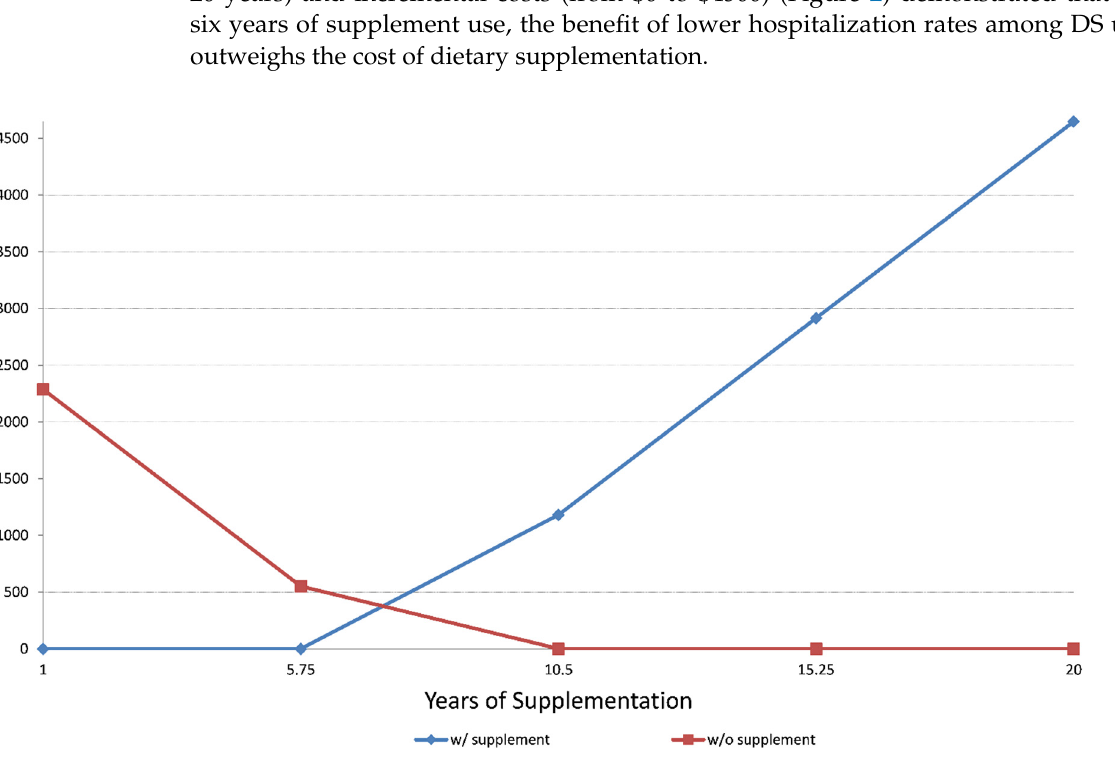
Figure 2. Sensitivity analysis showing incremental cost and years of supplementation. The probabilistic sensitivity analysis (Figure 3) demonstrates that the large portion of the CE ellipse in quadrant II is located below the cost-effectiveness threshold. This indicates that variation of the modeling parameters is unlikely to reverse the study conclusion about cost-effectiveness of DS use in cancer survivors.